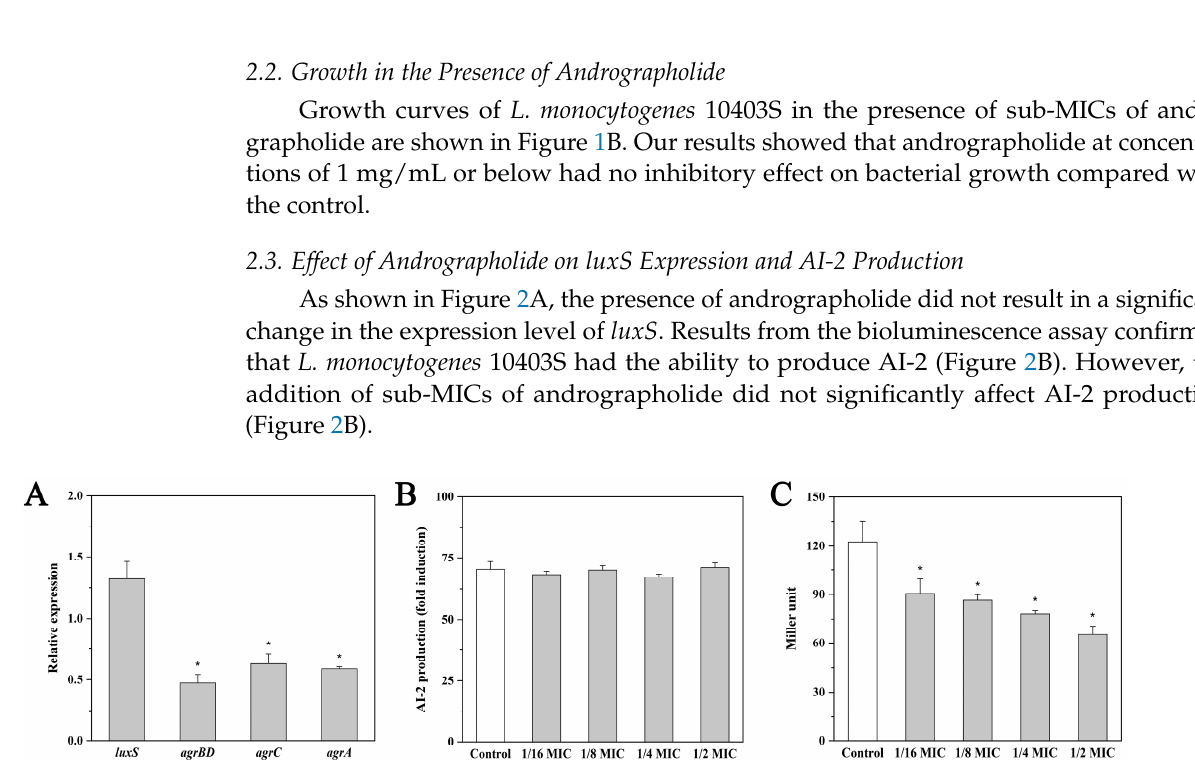
Figure 2. Effect of andrographolide on two QS systems in L. monocytogenes . ( A ) Relative expression levels of QS-related genes in L. monocytogenes 10403S grown in BHI with or without andrographolide (1 mg/mL). Results are presented as fold changes relative to the expression level of the target gene in L. monocytogenes 10403S in BHI. ( B ) The production of AI-2. Vibrio harveyi BB170 and Escherichia coli DH5 α were used as the positive control and the negative control, respectively. The relative activity of AI-2 was presented as a percentage of the positive control. ( C ) The agr promoter (P 2 ) activity. Error bars represent the standard deviation of triplicate experiments ( n = 3). The asterisk indicates a value statistically different from that of the control, with p <